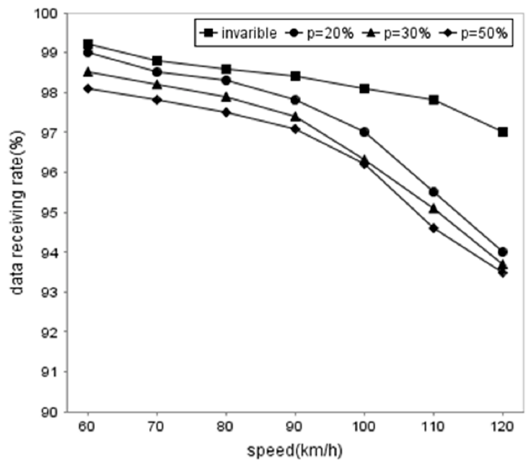
Figure 8. Comparison of data receiving rate generate in different p and average speed.